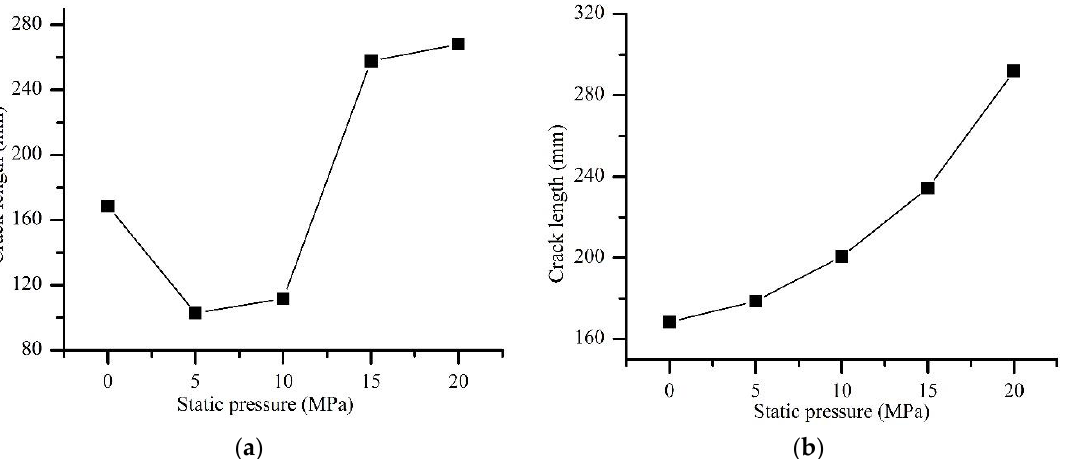
Figure 18. The relationship between the crack length and static pressure: ( a ) Group I; ( b ) Group II.